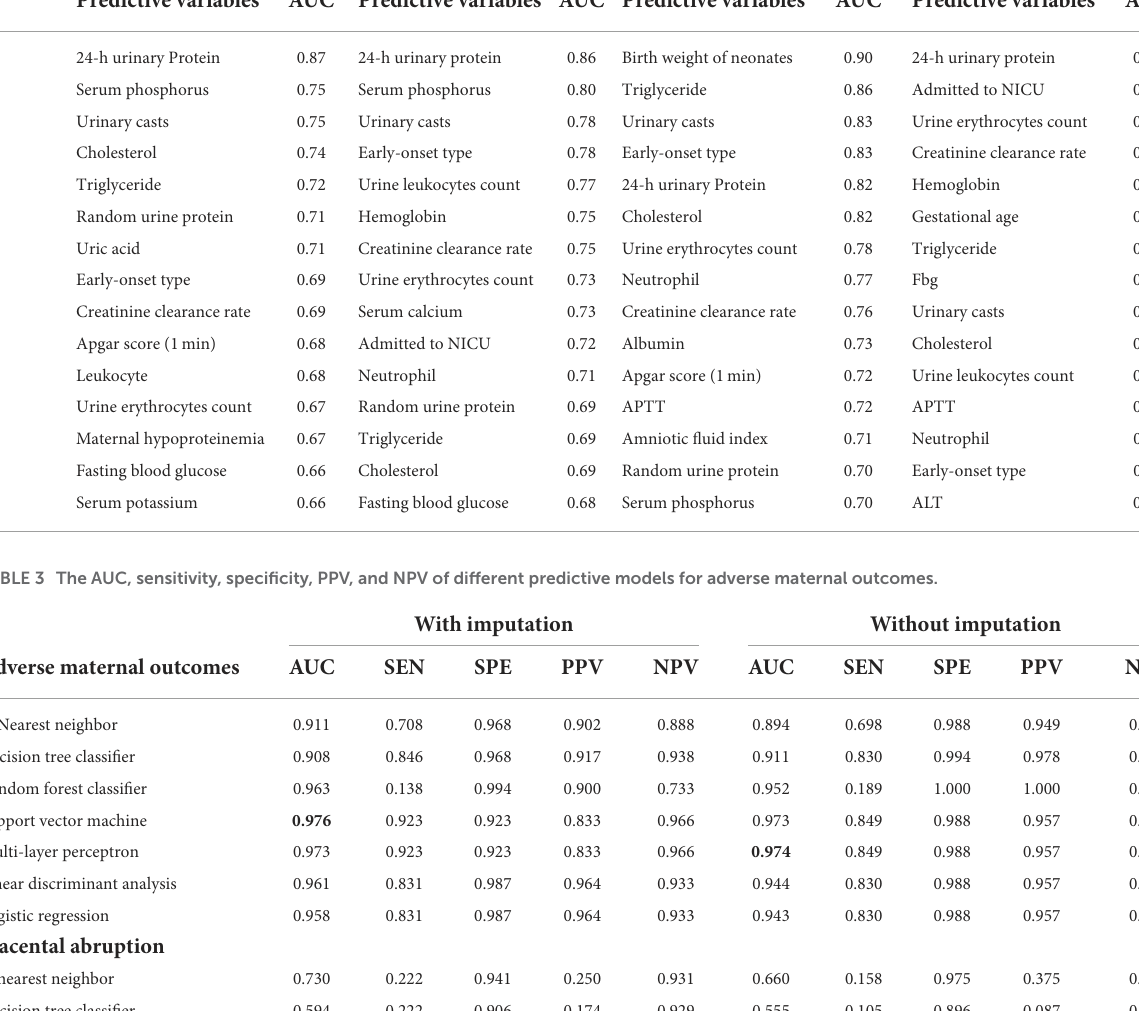
TABLE 2 Feature selection of TOP 15 adverse outcomes predictive variables according to the value of AUC calculated by DT algorithm.